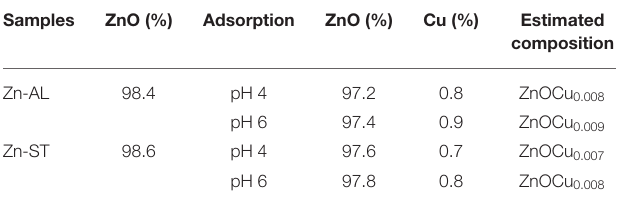
TABLE 5 | Compositional chemical analysis data by EDXRF (% element).